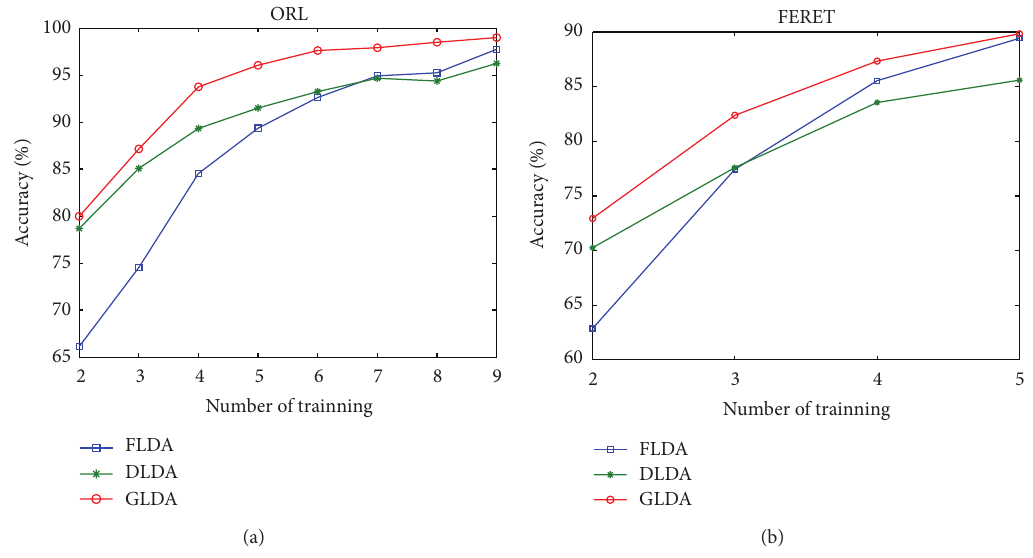
Figure 3: Rank 1 accuracy versus training number on the ORL face database (b) and FERET face database (a).